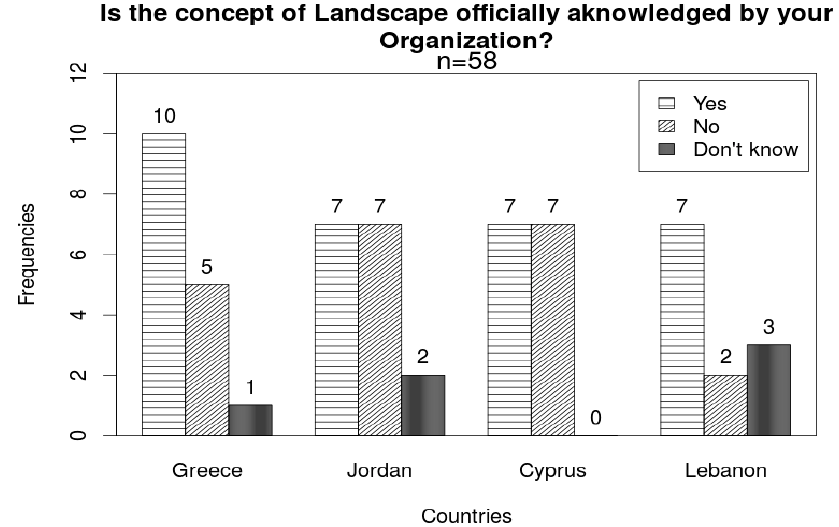
Figure 1. Frequencies of answers to the question “Is the concept of Landscape officially acknowledged by your Institution/Organization?” by country of residence.